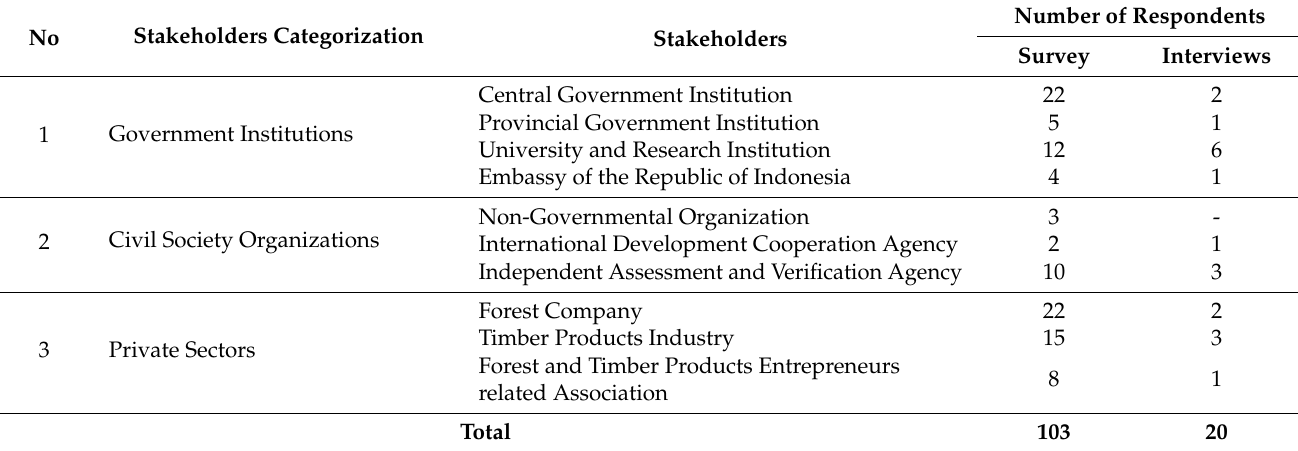
Table 1. Categorization of stakeholders for survey and interviews.